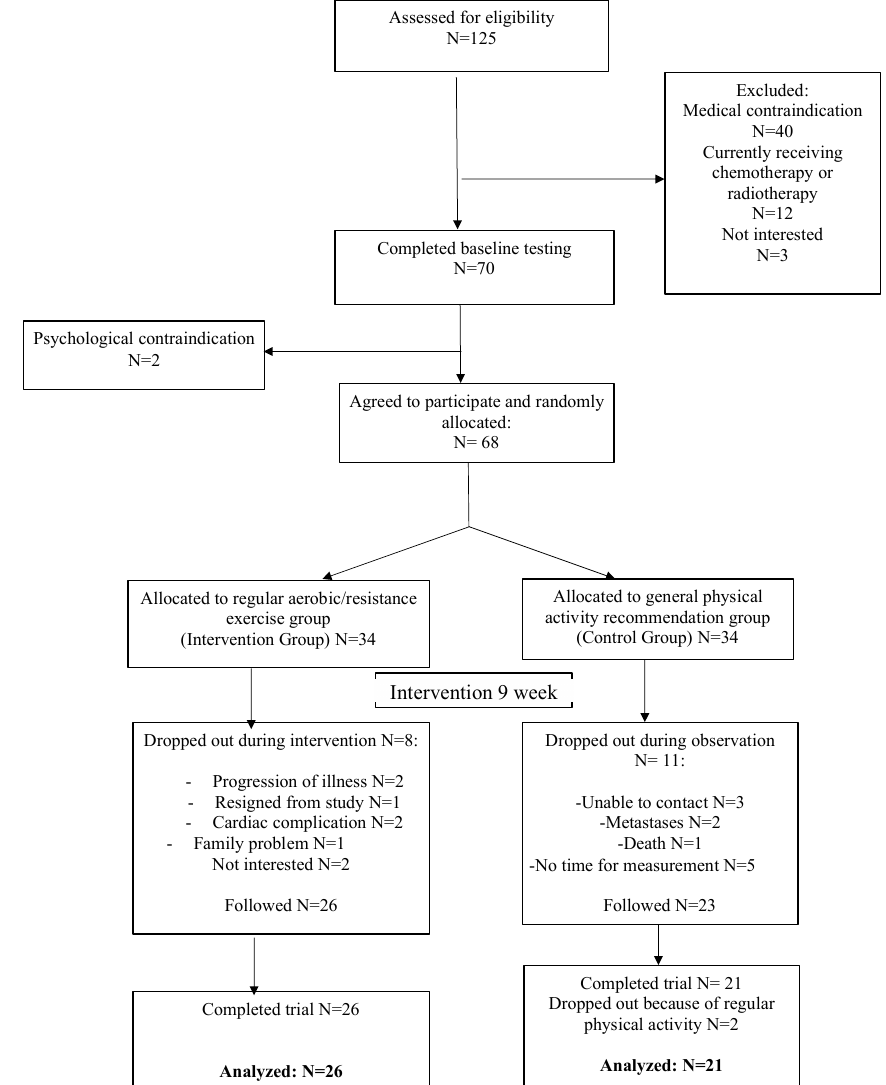
Figure 1. CONSORT